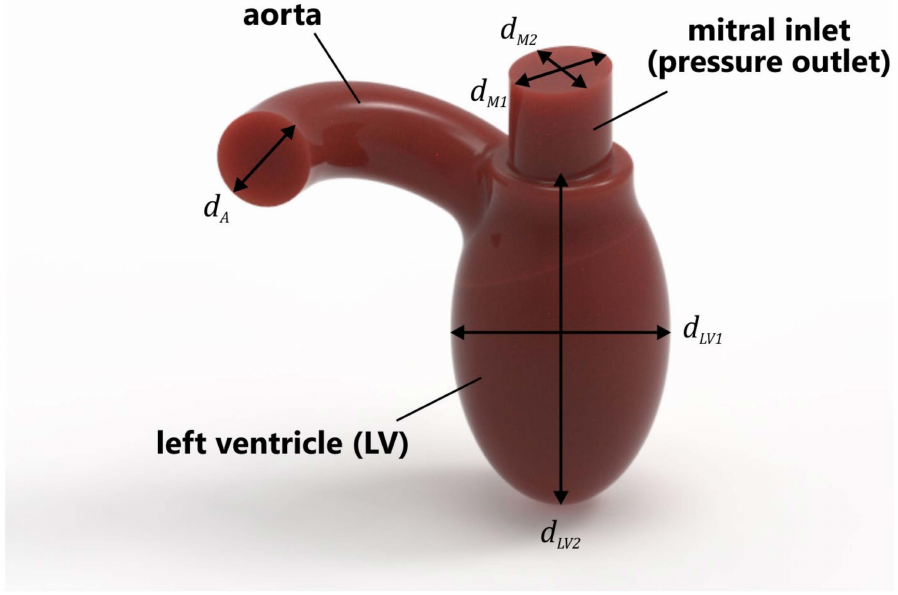
Figure 1. Simplified geometry of